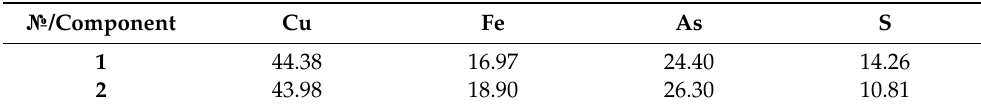
Table 2. Normalized chemical composition of the FeAsS residue before ( 1 ) and after ( 2 ) treatment in sodium sulfide solution (wt. %).